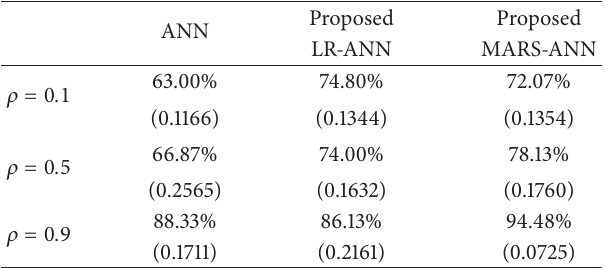
Table 11: AIR comparison of the classical-single stage and the proposed models.